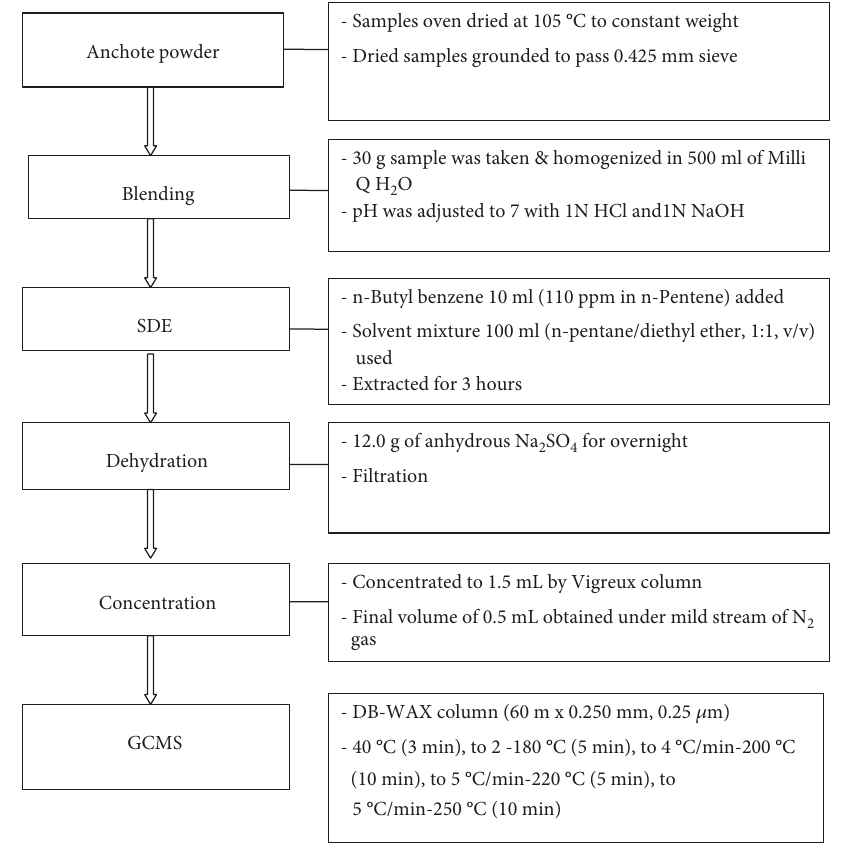
Figure 1: Schematic diagram for analysis of volatile fl avor compounds of anchote leaf and tuber samples. Table 1: Retention time of n-alkane mixture for GC-MS retention